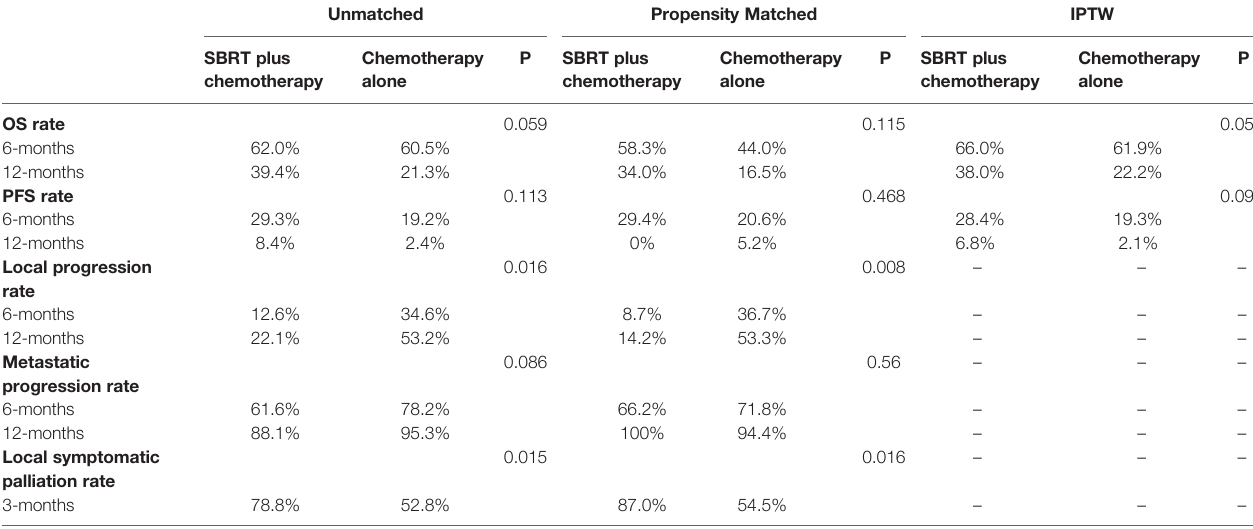
TABLE 2 | Summary of estimated treatment effect for main outcome measures in unmatched, propensity Matched and IPTW groups.